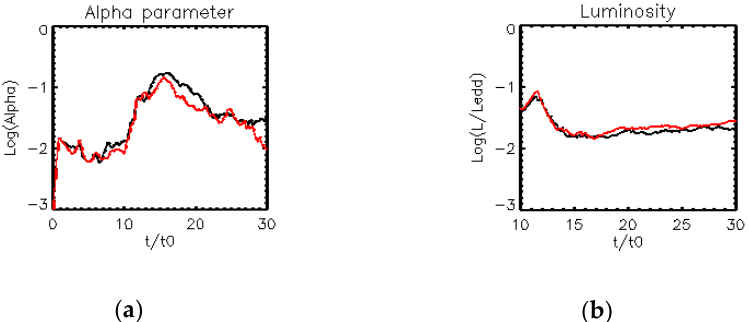
Figure 4. Evolutions of the averaged magnetic stress and integrated luminosity. Black lines show the results of Model 1 without thermal conduction. Red lines show the results of Model 2 including thermal conduction. ( a ) Averaged viscous alpha parameter α MHD = Integration is done in the domain of 0.4 < r / R 0 < 1.2, 0 < ϕ < 2 π and − 0.3 < z / R 0 < 0.3. ( b ) Integrated luminosity normalized by the Eddington luminosity. Integration is done in the domain of r / R 0 < 10, 0 < ϕ < 2 π and − 10 < z / R 0 < 10 excluding the region of / 2 . Colors denote same meaning as ( a ).